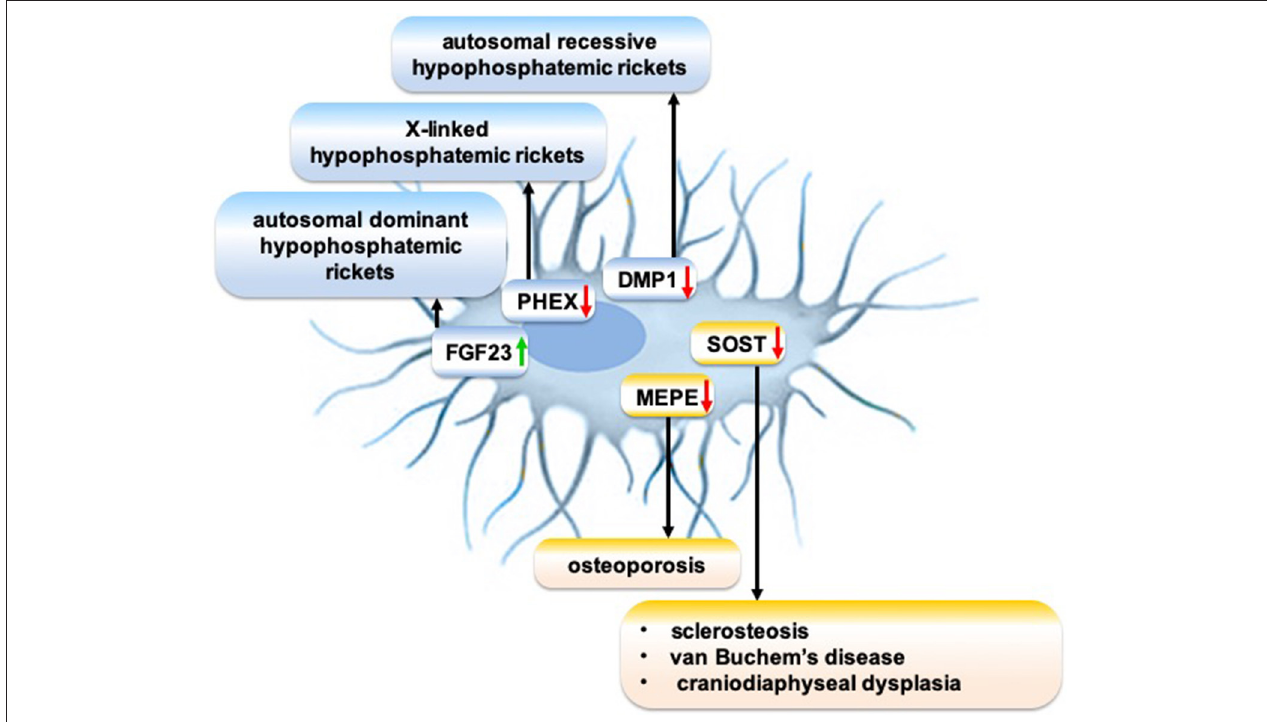
FIGURE 2 | Schematic showing the role of disrupted expression of osteocytic proteins on the pathophysiology of rare bone diseases. Green arrow: Gain-of-function mutation; red arrow: Loss-of-function mutation.